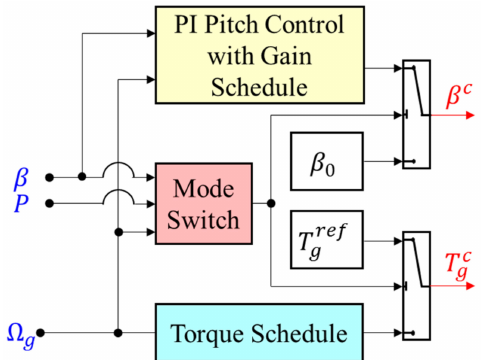
Figure 4. Block diagram of the proportional integral (PI) control algorithm.